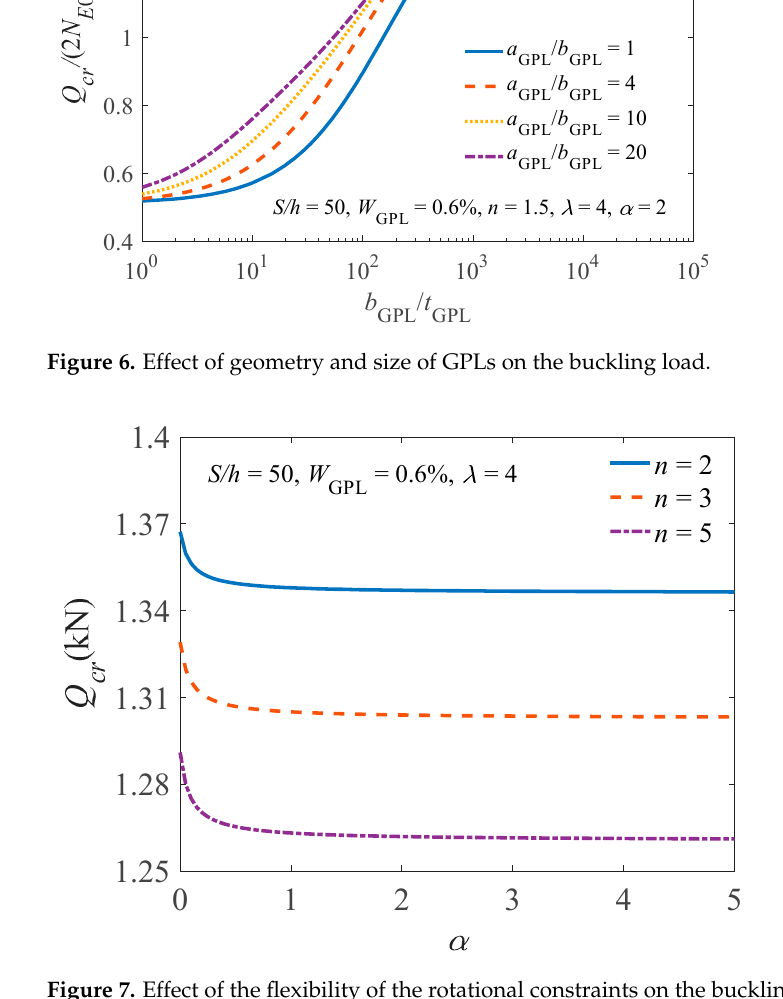
Figure 7. Effect of the flexibility of the rotational constraints on the buckling load.